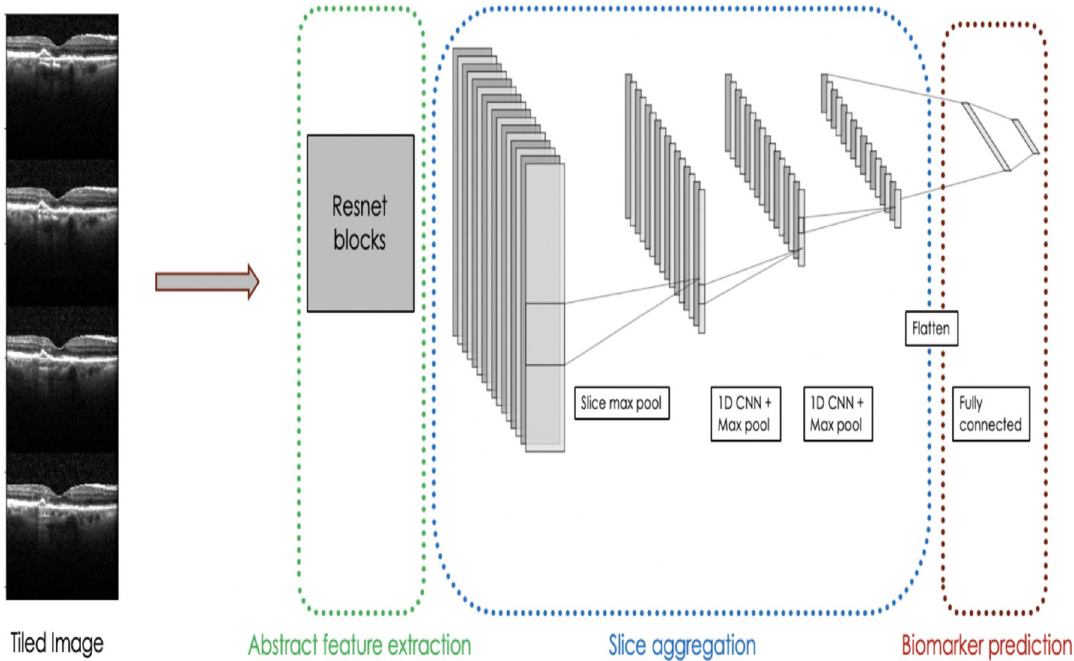
Fig. 10 SLIVER-net. Our model operated on a 2d tiling of the OCT volume. Resnet18 served as the abstract feature extractor, and the representations for each slice were aggregated using slice integration and a 1D CNN. Finally, biomarkers were predicted using fully connected